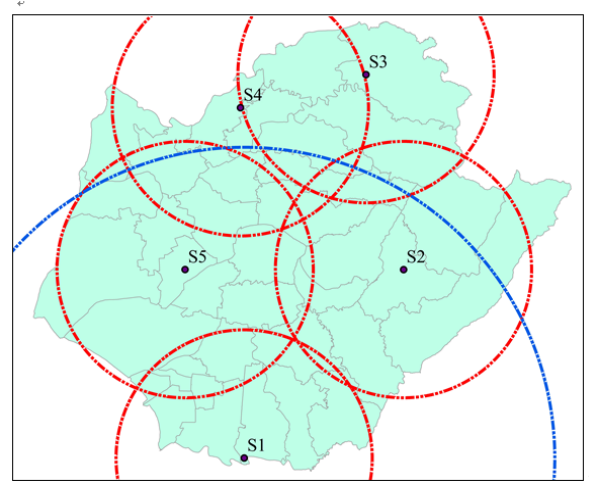
Figure 10. LoRa and APRS GTS coverage in Tainan City.